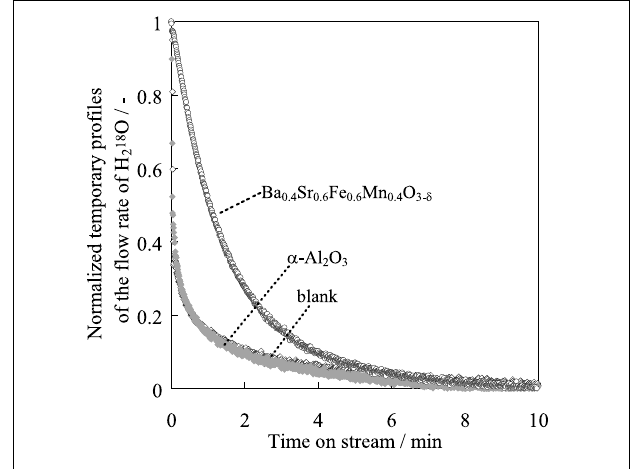
FIGURE 7 | Normalized temporary profile of H 18 2 O flow rate over α -Al 2 O 3 or Ba 0 . 4 Sr 0 . 6 Fe 0 . 6 Mn 0 . 4 O 3 − δ